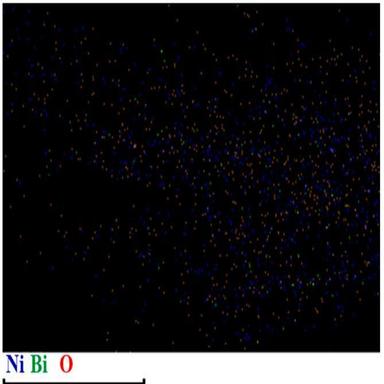
SEM-EDS mapping image of NBO material.